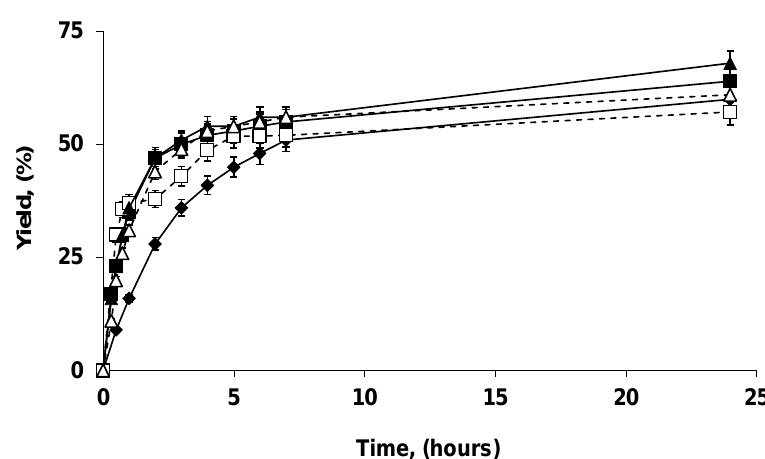
Figure 9. Synthesis of biodiesel from sunflower oil and methanol catalyzed by di ff erent lipase biocatalysts. The experiments were performed as described in the Methods section. Rhombus, continuous line, filled symbol: commercial Lipozyme TL IM; filled squares, continuous line, TLL immobilized on octadecyl metacrylate, empty squares, dotted line: immobilized TLL coated with PEI; filled triangles, continuous line, ET immobilized on octadecyl metacrylate, empty triangles, dotted line: immobilized ET coated with PEI.